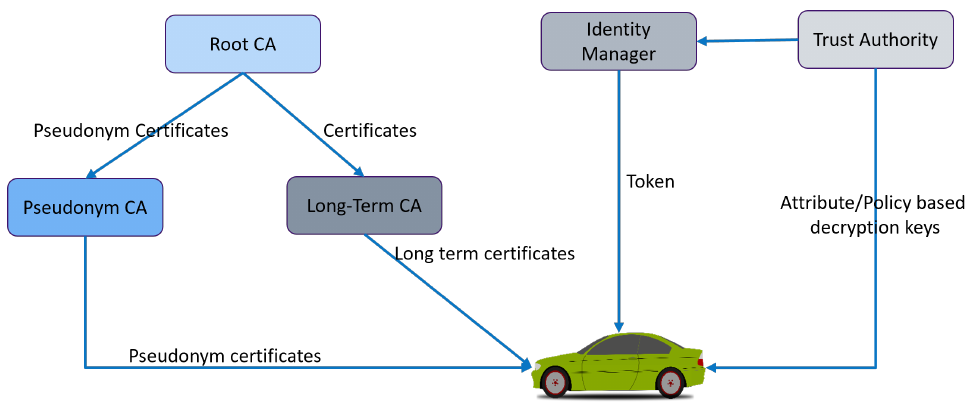
Figure 1. VPKIbrID Security Model(From